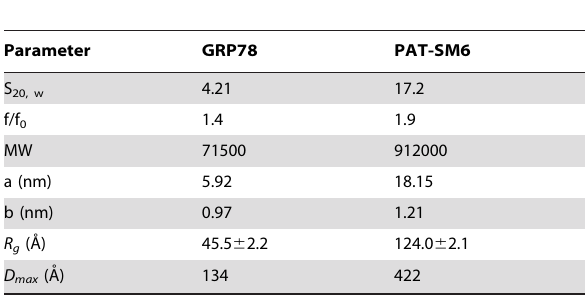
Table 1. Sedimentation velocity and SAXS analysis of GRP78 and PAT-SM6.